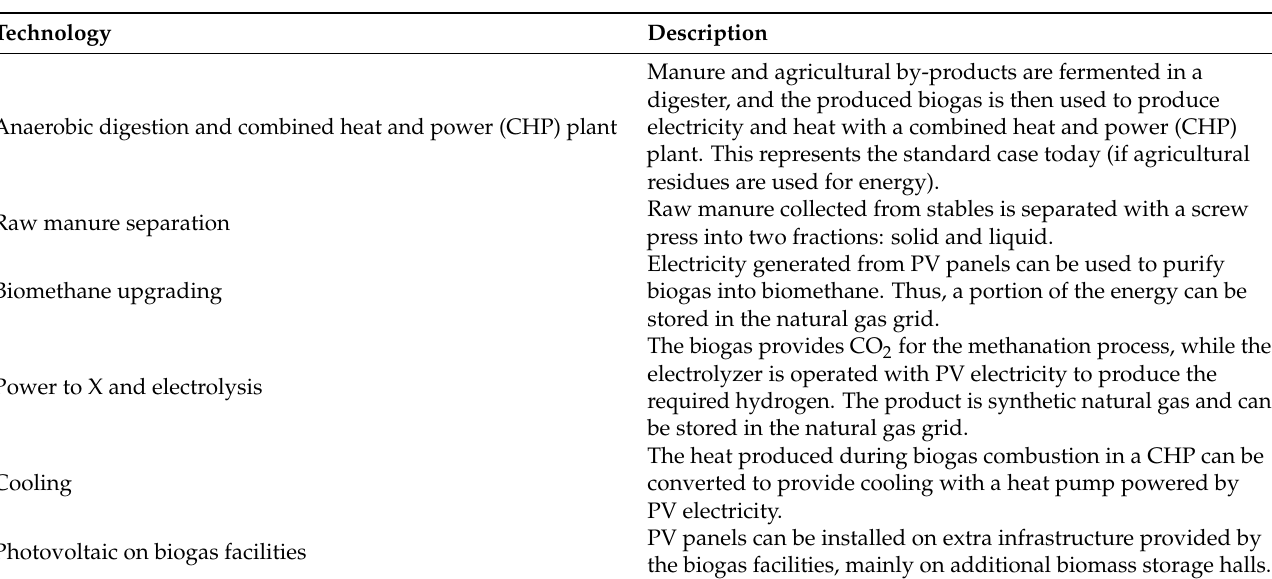
Table 1. Identified promising technologies for complementarities between biomass and solar re- sources for energy in the Swiss agricultural